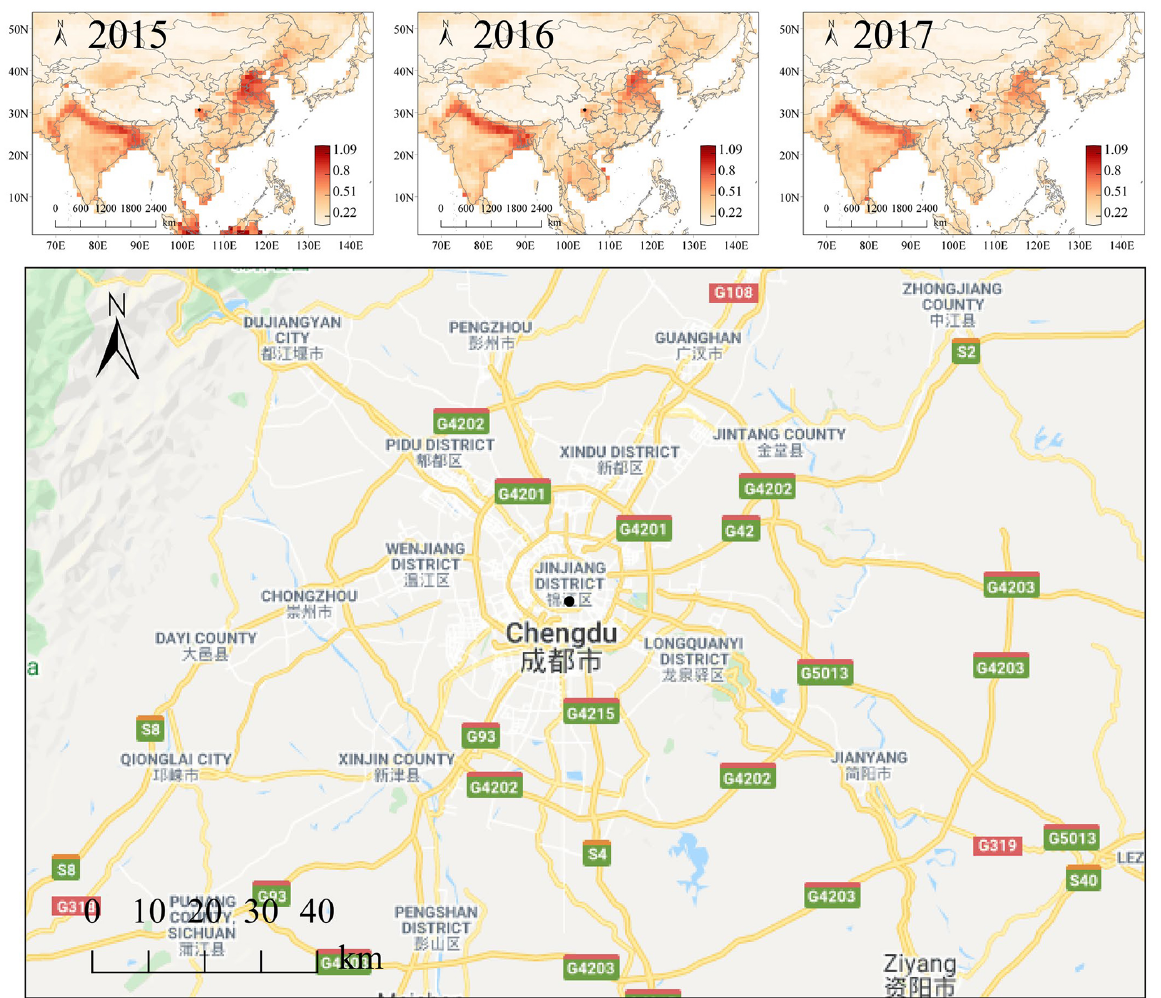
Figure 1. Observation site in Chengdu. The image on the top shows the aerosol optical depth (AOD, 550nm) from 2015 to 2017 (National Aeronautics and Space Administration, 2019, last access: 17 June 2020). The black dot in the image on the bottom shows the location of the observation site in Chengdu (background map from © Google Maps, last access: 17 June